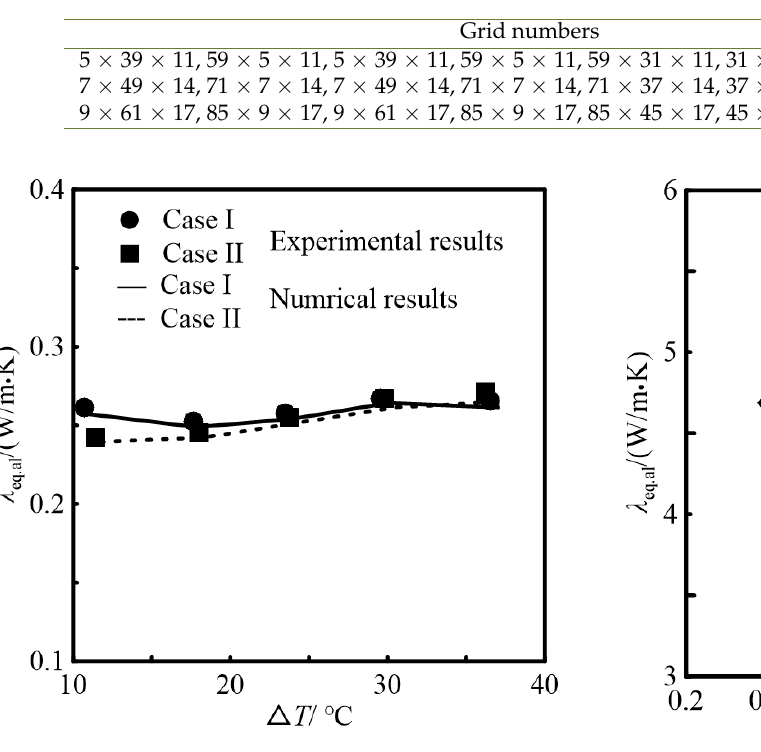
Fig. 6. The equivalent thermal conductivity of the aluminum extrusion (Case II, the test wall is vertically